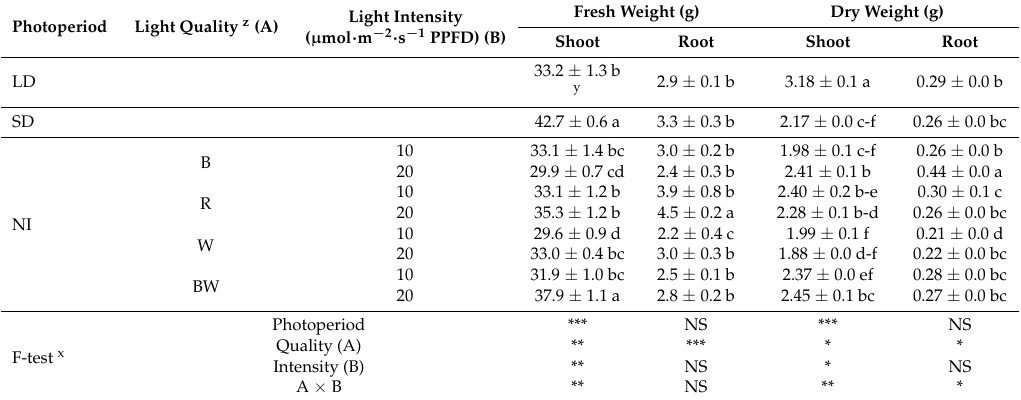
z Refer to Figure 1 for details on the NIL quality. y Mean (n = 3) separation within columns by Duncan’s multiple range test at 5% level. x NS, *, **, ***: Non-significant or significant at p ≤ 0.01.